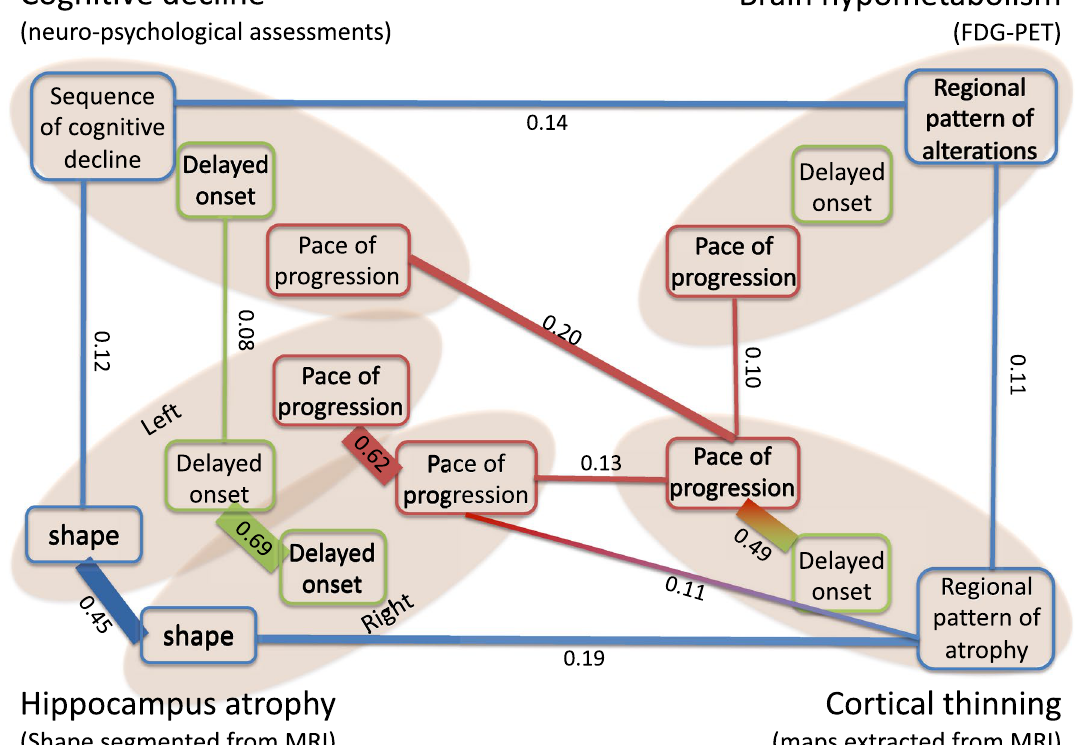
Figure 6. Graph of conditional correlations among individual parameters. An edge is shown between two parameters if there is a significant correlation between them given all other parameters. The width of the edge is proportional to the value of the conditional correlation, which is also reported on the edge. The color of the parameter denotes its type and its position the modality. The image was obtained using the software Microsoft PowerPoint